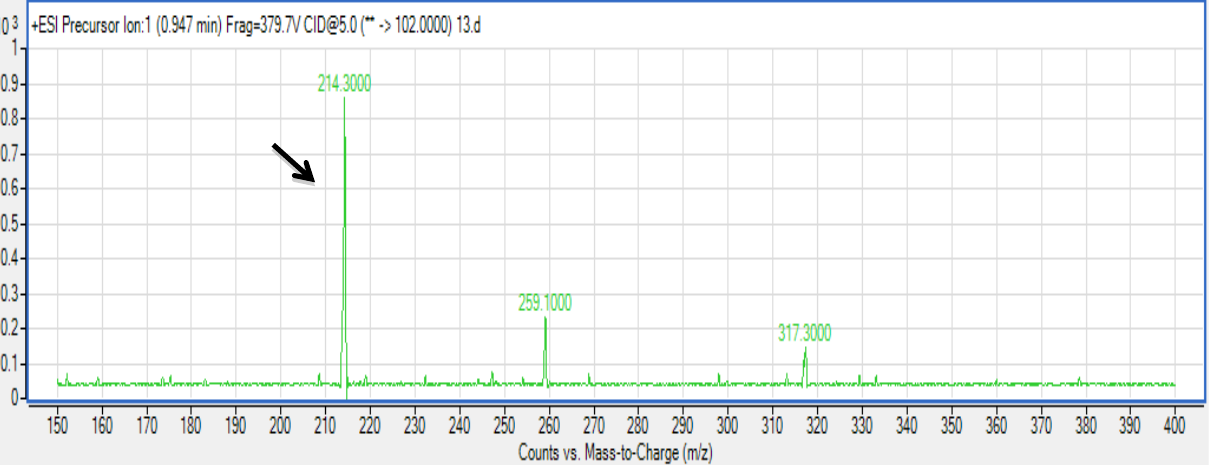
Figure 3. Mass spectrometry analysis of spent supernatants extract Enterobacter sp. strain M004. ( Upper Panel ) : mass spectra of 3-oxo-C6 HSL ( m / z 214.3000) (marked by arrow). ( Lower Panel ) : mass spectra of 3-oxo-C8 HSL ( m / z 242.2000) (marked by